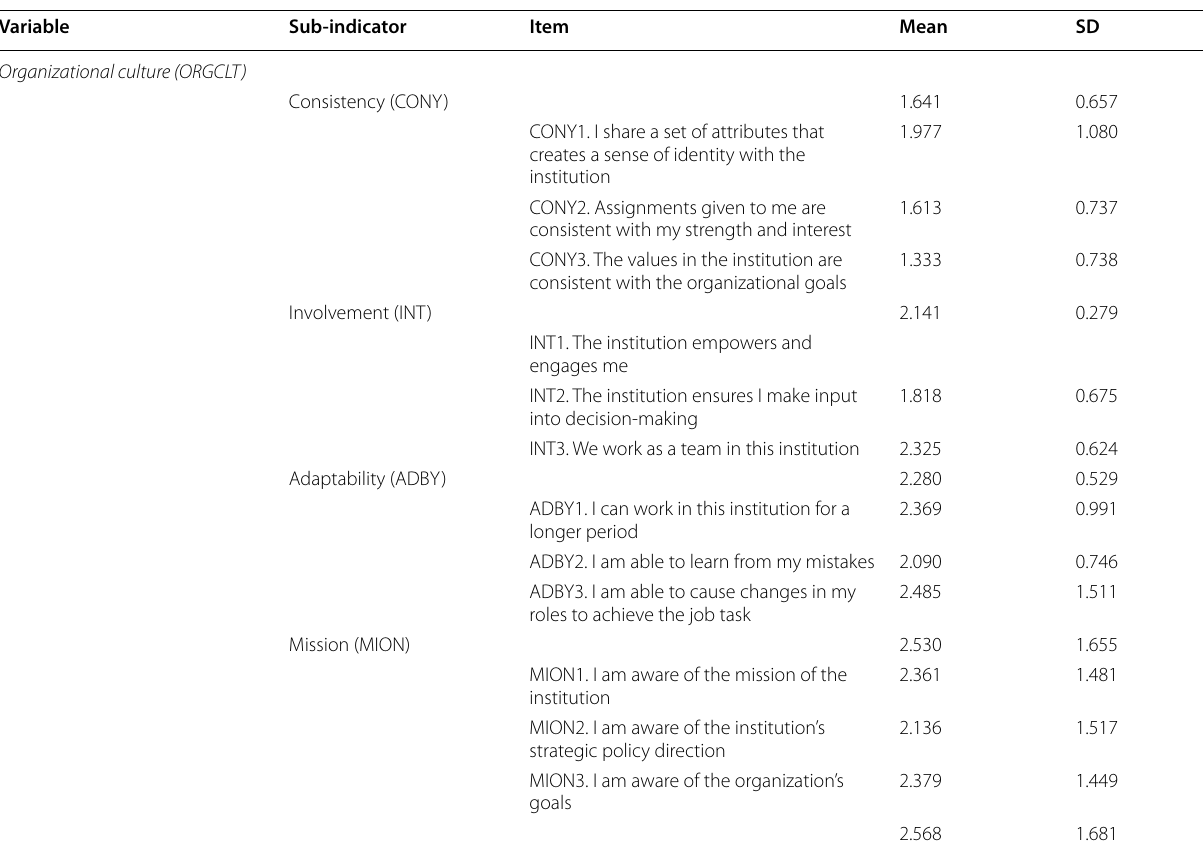
Table 2 Organizational culture